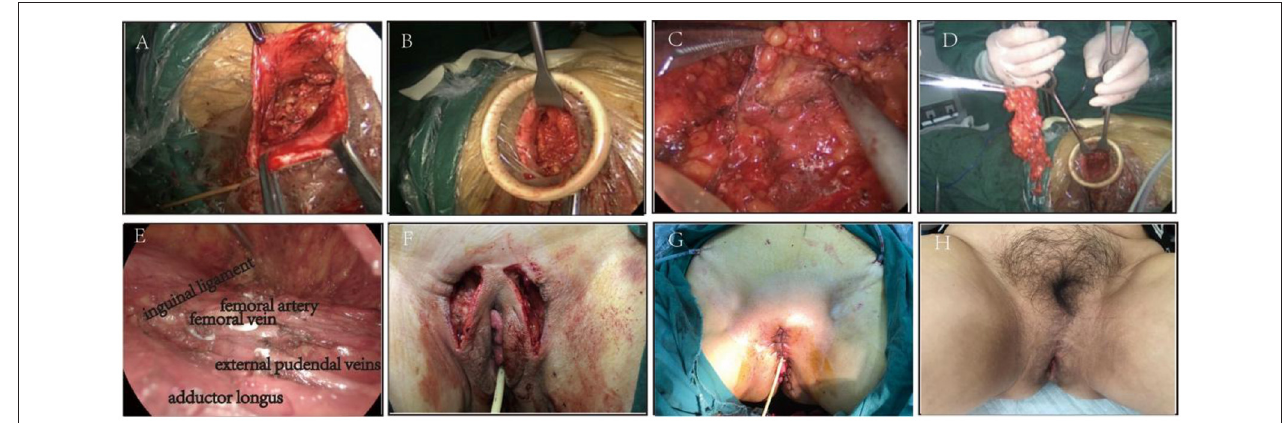
FIGURE 1 | (A) Make a single incision at the outer margin of the lesion. (B) Create the surgical field with a suspension hook. (C,D). Cut off the superficial and deep inguinal lymph node under the endoscope (Right side). (E) Complete removal of lymph nodes (Left side). (F) Performance after lymph node removal. (G) Performance after radical vulvectomy. (H) The appearance of the vulva six months after the operation.